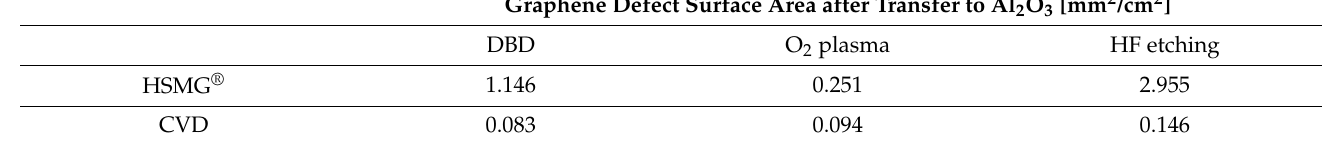
Table 3. Graphene defects analysis based on optical microscope